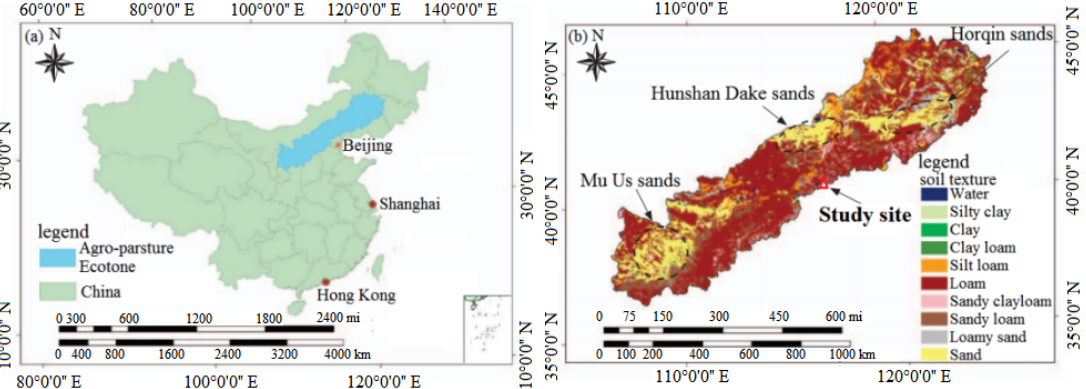
Figure 1. Location of study site. ( a ) The agro-pasture ecotone in North China. ( b ) The study site.